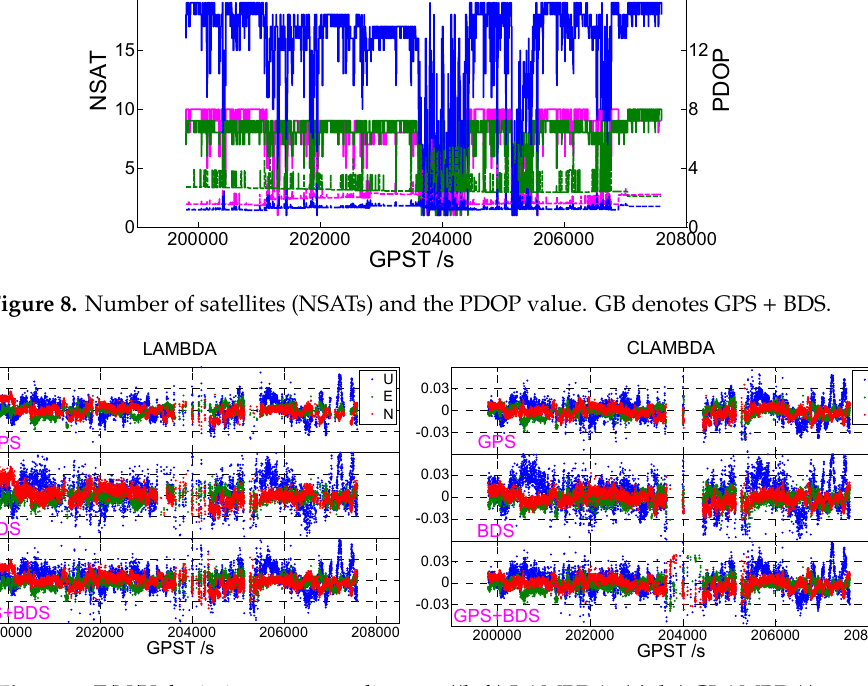
Figure 9. E/N/U deviation sequence diagram (( left ) LAMBDA, ( right ) CLAMBDA). Figure 9. E / N / U deviation sequence diagram (( left ) LAMBDA, ( right )